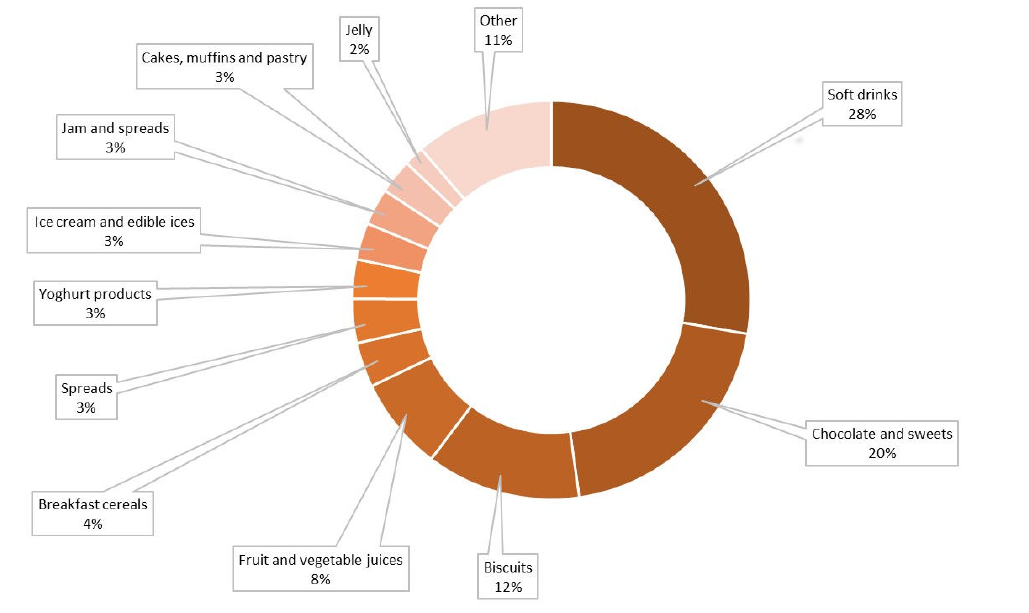
Figure 3. Relative contribution of di ff erent categories to the amount of free sugar